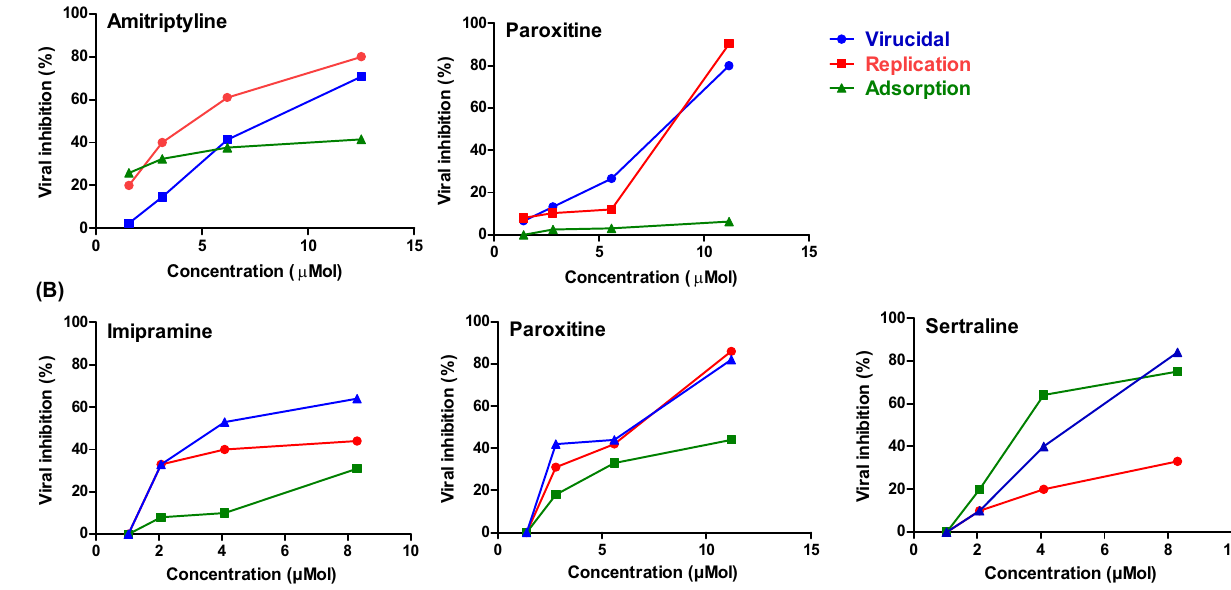
Figure 4. Mode of action for promising antidepressant drugs against SARS-CoV-2 ( A ) and MERS-CoV ( B ).